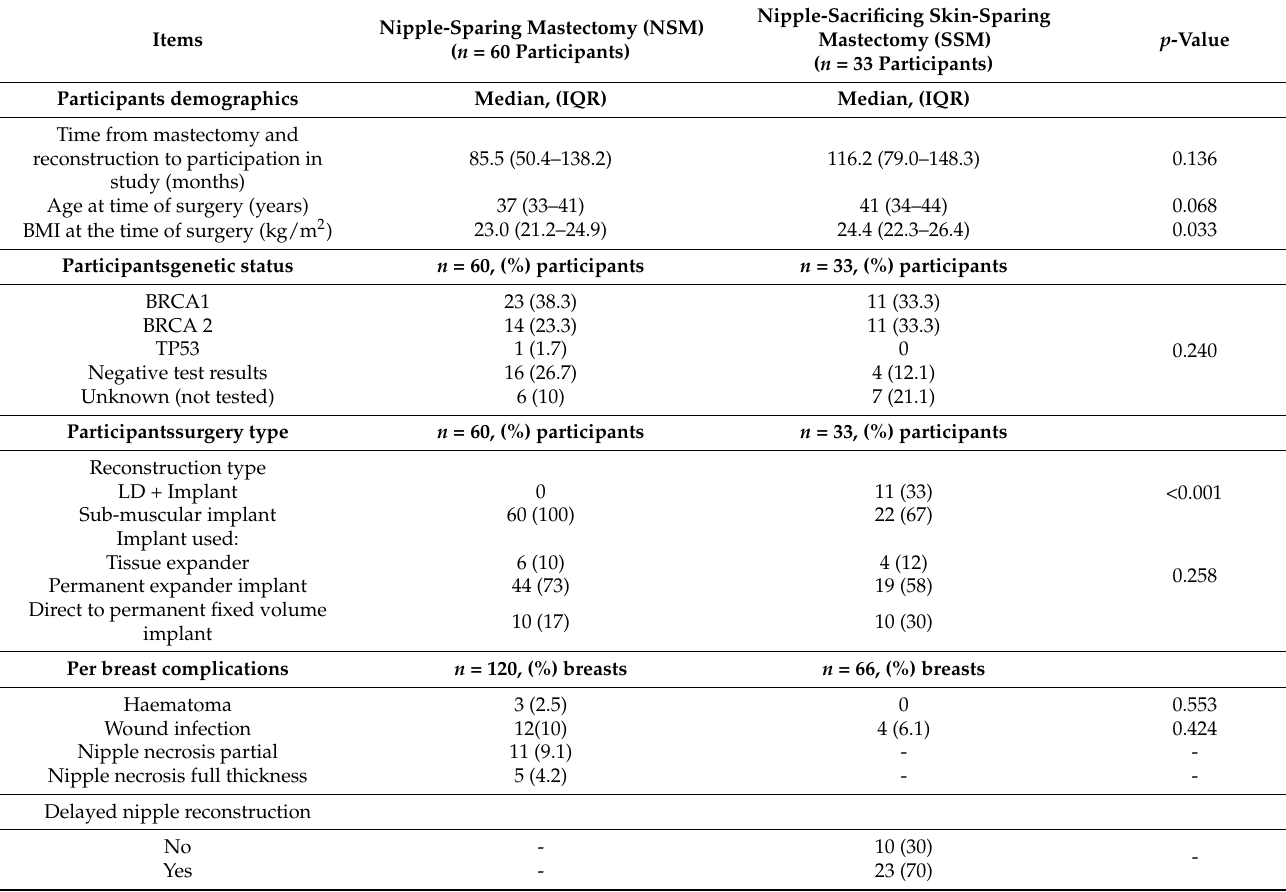
Table 1. Participant demographics and reconstruction type and surgical